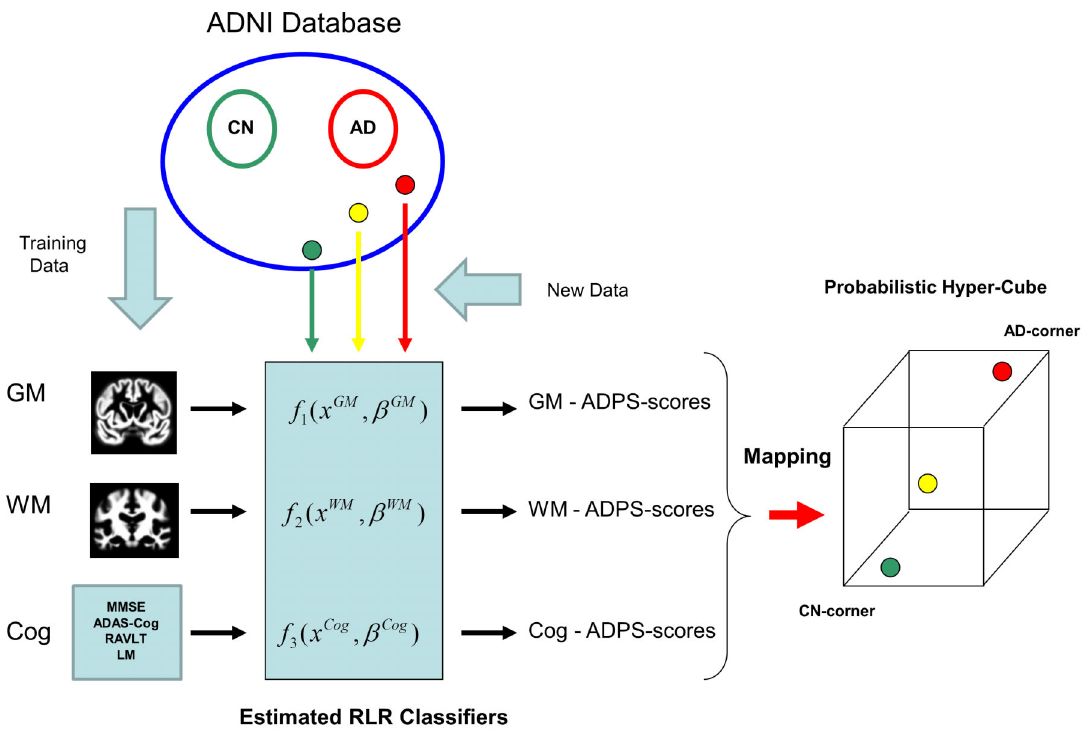
Figure 1. The concept of a probabilistic hypercube is illustrated. The probability hypercube can be interpreted as a geometrical representation of the output of a set of generative classifiers, each one estimated with different types of data. The set of AD-PS scores corresponding to a given individual define a position inside a unit hypercube. The position inside the hypercube for three individuals is illustrated.